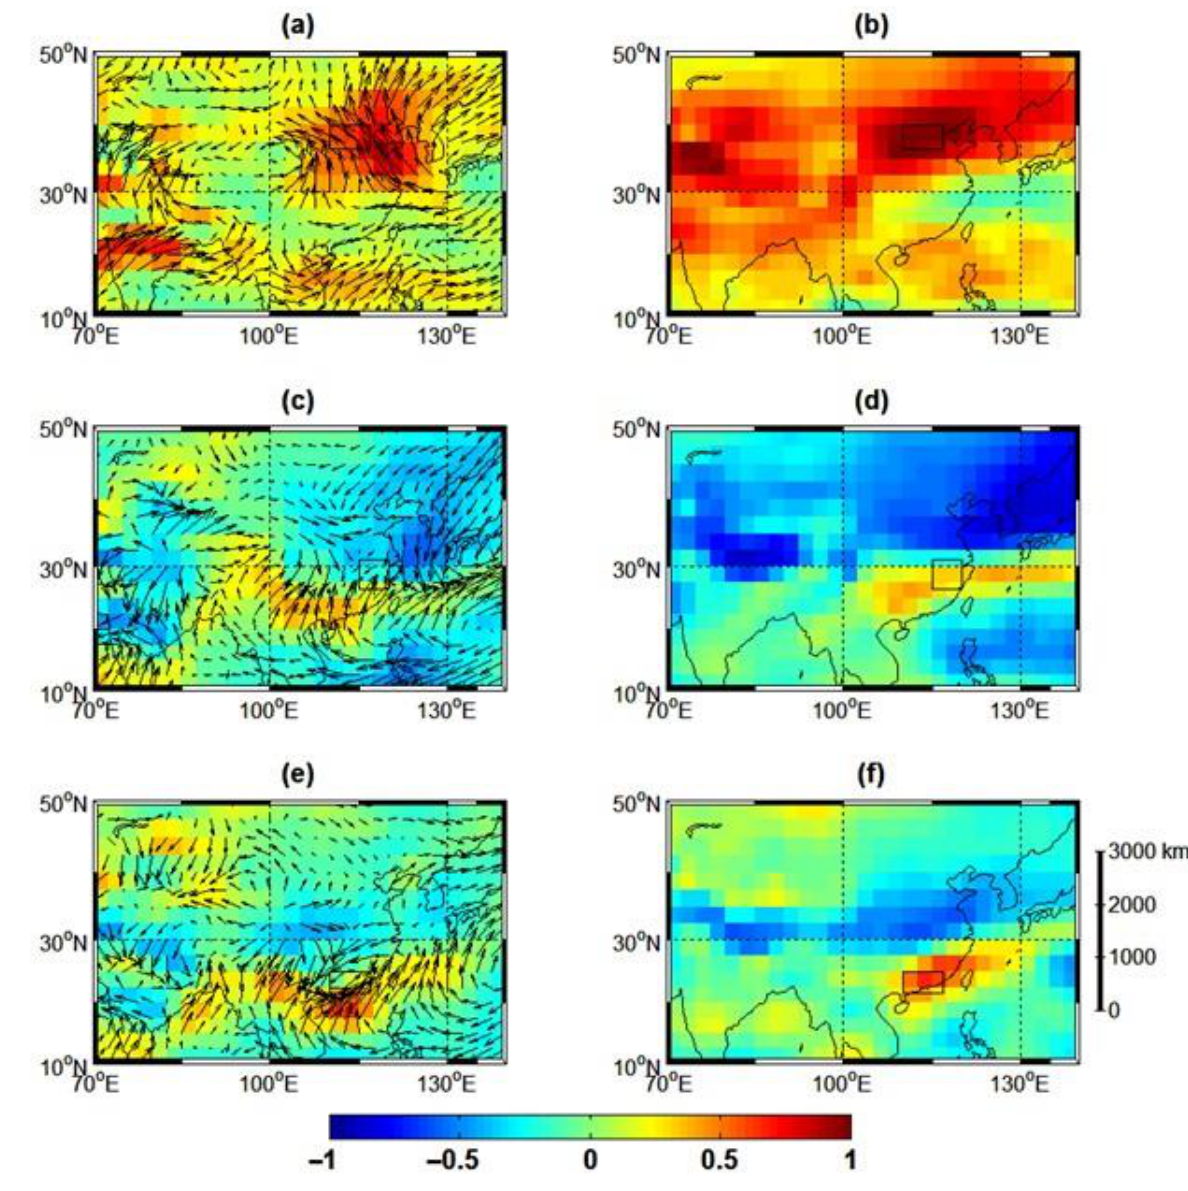
Figure 3. Composite of standardized anomalies of IVT magnitude for extreme event days in each region (shading) ( left column) and standardized potential pseudo-equivalent temperature ( θ se ) anomalies ( right column) for extreme event days in ( a , b ) North China (NC), ( c , d ) Yangtze River Valley (YRV), and ( e , f ) South China (SC) for JJA 1980–2019. Vectors (in a , c and e ) depict the standardized anomalies of the u and v components of IVT.